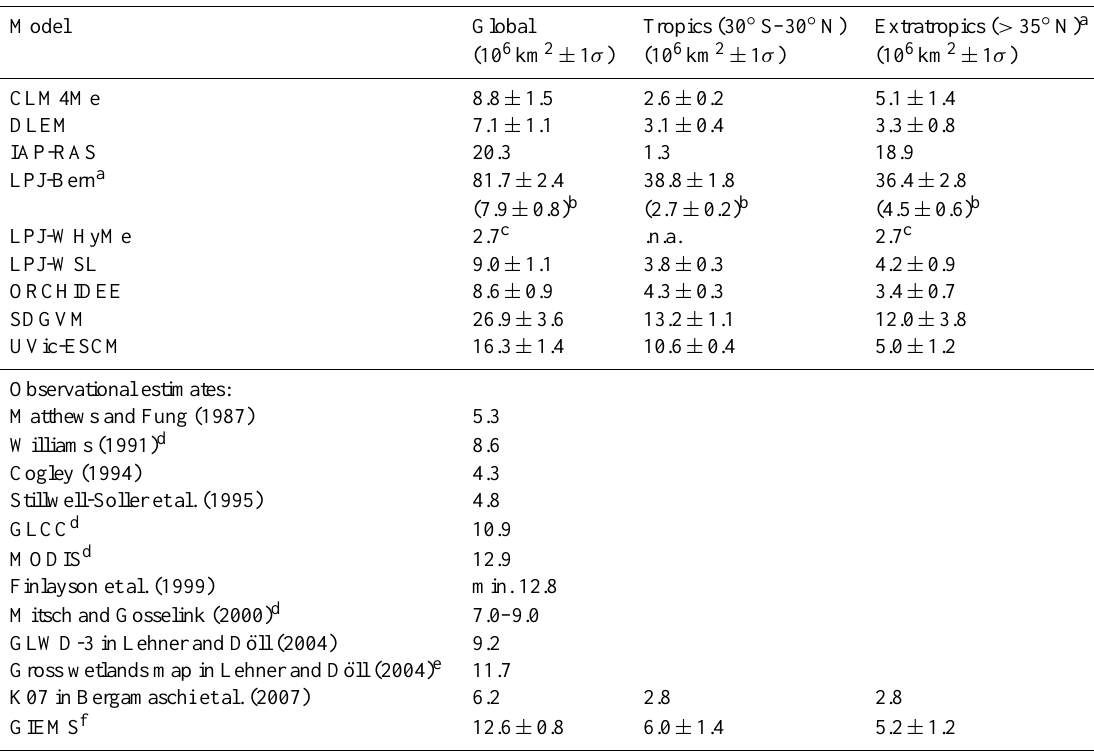
Table 2. Mean annual maximum wetland extent for participating models over the period 1993–2004 (Experiment 2-Transient). For a descrip- tion of how each model determines wetland extent, see Table 1 and Wania et al. (2012). GLCC is the USGS Global Land Cover Characteristics database (Loveland et al., 2000). MODIS is the MODerate resolution Imaging Spectroradiometer land cover product (ORNL DAAC, 2000). Some of the observational estimates do not include transient wetlands (GLCC & MODIS), and are not specific to the 1993–2004 period with the exception of the GIEMS